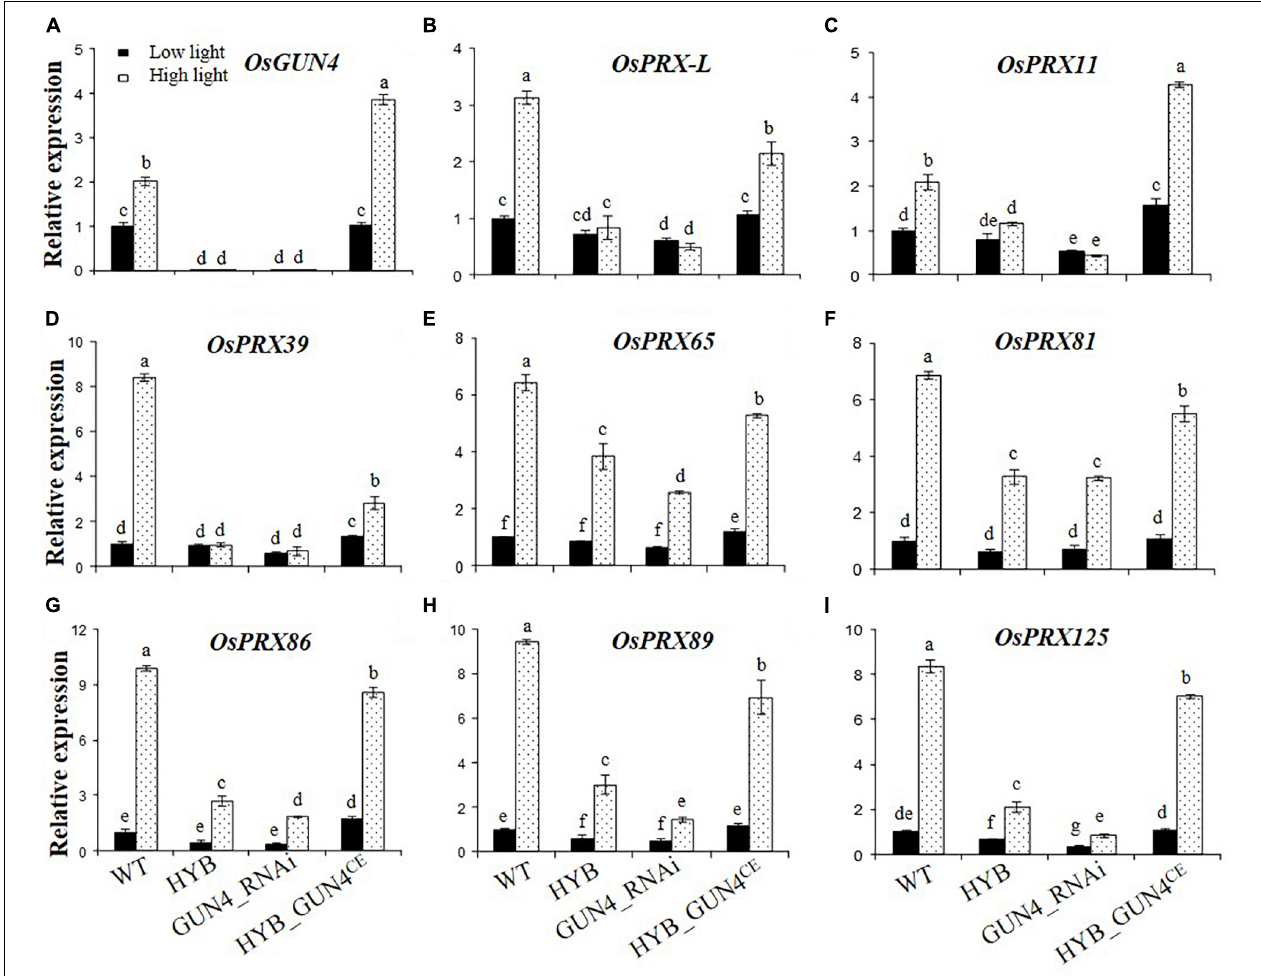
FIGURE 7 | Relative expression levels of OsGUN4 and 8 peroxidase-encoding genes in rice protoplasts. Relative expression levels of OsGUN4 (A) and 8 peroxidase-encoding genes (B–I) in protoplasts of the wild-type (WT; c.v. LTB) and its OsGUN4 epigenetic mutant HYB, and in LTB protoplasts transformed with an RNAi vector of OsGUN4 (GUN4_RNAi) and HYB protoplasts with an OsGUN4 complementary vector (HYB_GUN4 CE ). Protoplasts were prepared from leaves of seedlings 35 days after germination (DAG) grown under low light (100 µ mol m − 2 s − 1 ) and transformed with interference or complementary vectors. Transformed protoplasts were initially kept under dark for 1 h and then grown under low (100 µ mol m − 2 s − 1 ) or high light (1000 µ mol m − 2 s − 1 ) for 6 h, before subject to total RNA extraction. Expression levels are reported relative to that of the WT protoplasts grown at low light, which was assigned a value of 1. Values are means ± SD ( n = 6) and analyzed for significant differences by two-way ANOVA followed by the Tukey’s multiple comparison test, P < 0.05.